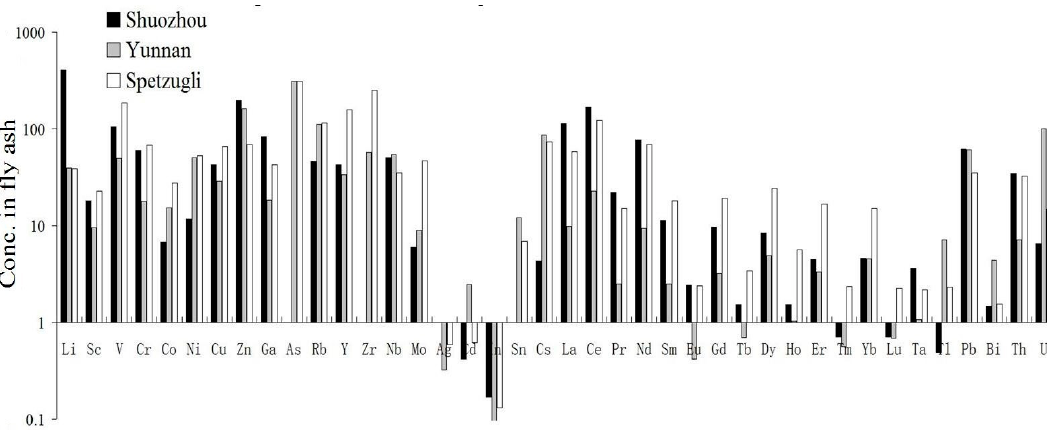
Figure 2. Relative concentrations of a number of trace elements in fly ash in Shuozhou, Yunnan, and Spetzugli.